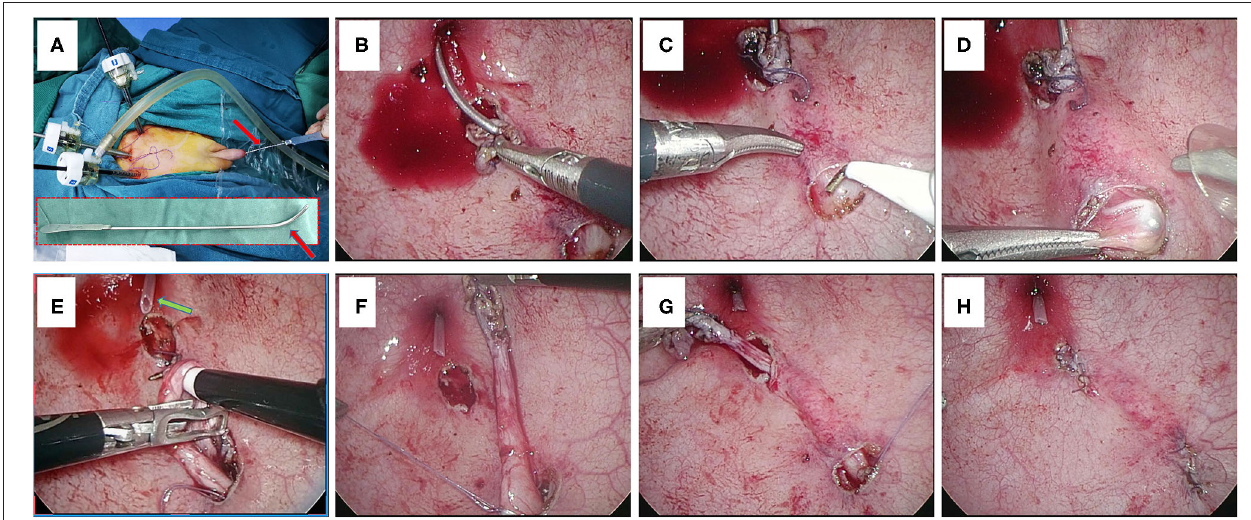
FIGURE 2 | (A) Placement of a urethral sound through the urethra. Red arrows indicate the urethral sound. (B) The urethra sound is inserted into the ureter. (C) The end of the urethral sound is pushed forward to reach the location of the new hiatus. (D) The retrovesical ureter is uplifted by the end of the urethral sound. (E) The distal ureter is further mobilized through the new hiatus. Green arrow indicates the urethral catheter. (F) The distal ureter is pulled into the bladder through the new hiatus. (G) The distal ureter is moved through the submucosal tunnel. (H) The ureteral orifice is anastomosed to the original hiatus.